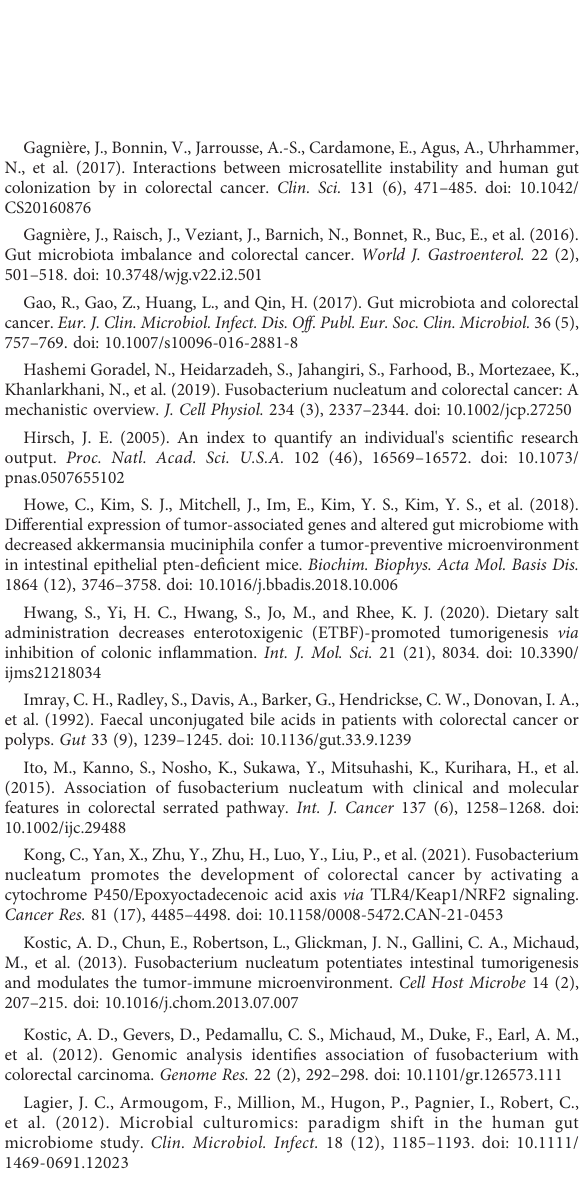
SUPPLEMENTARY TABLE 3 The top 10 most productive authors in the fi eld of microbiota and colorectal cancer research from